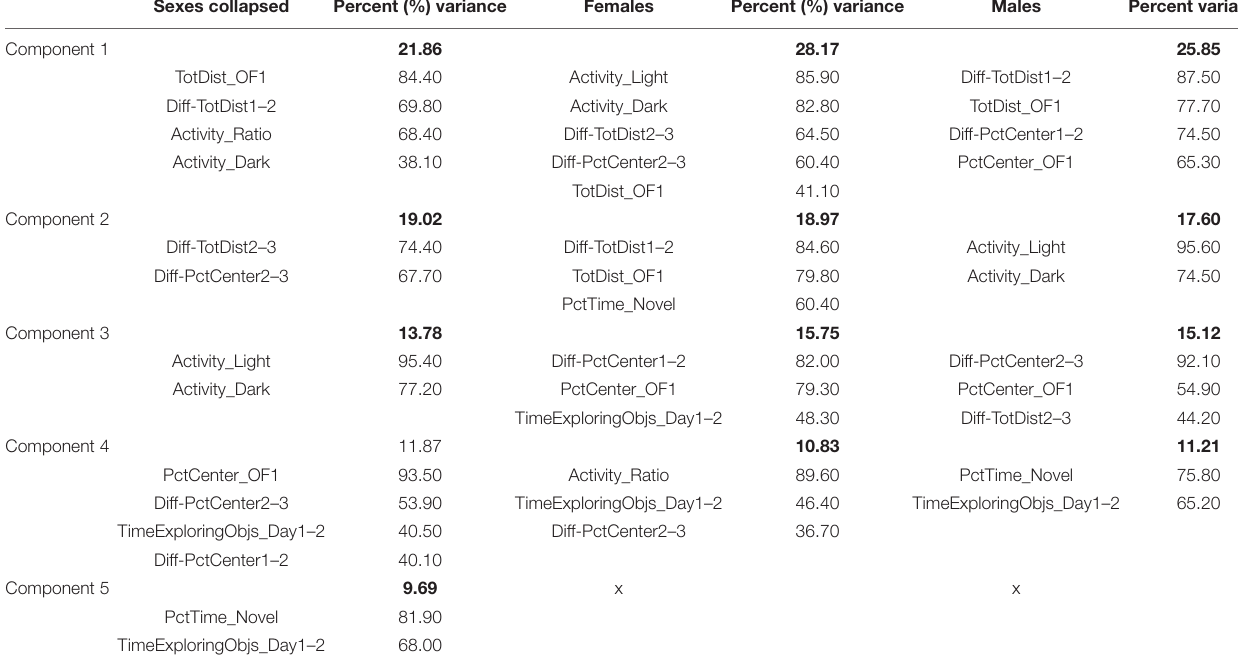
TABLE 2 | Results from PCA in female and male mice. Sexes collapsed Percent (%) variance Females Percent (%) variance Males Percent variance